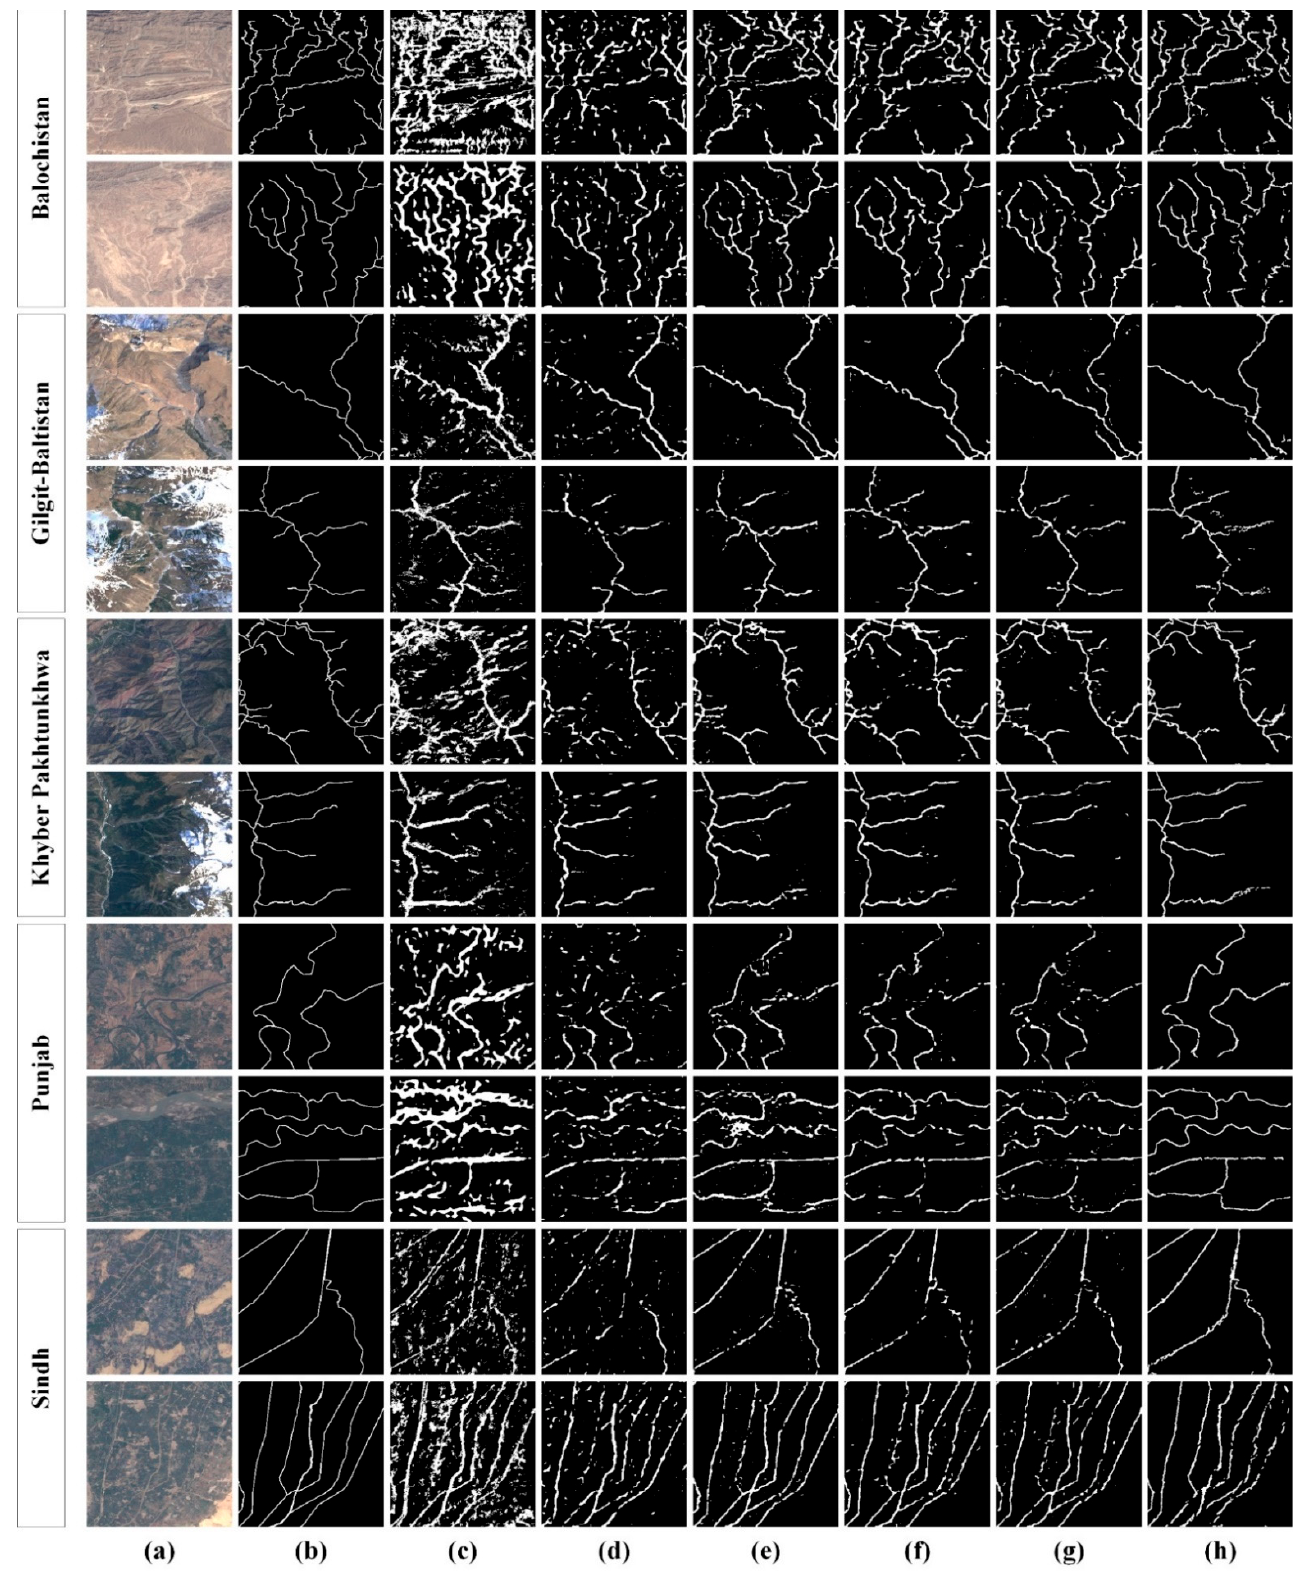
Figure 8. Comparison of water channel segmentation results by the AUnet and other SOTA solutions using different study areas of Pakistan in the local dataset: ( a ) raw input patches, ( b ) ground-truth pixel labels, ( c ) FCN-32s [24], ( d ) FCN-8s [24], ( e ) U-net [25], ( f ) SegNet [26], ( g ) DeepLabv3+ [27], and ( h ) AUnet.